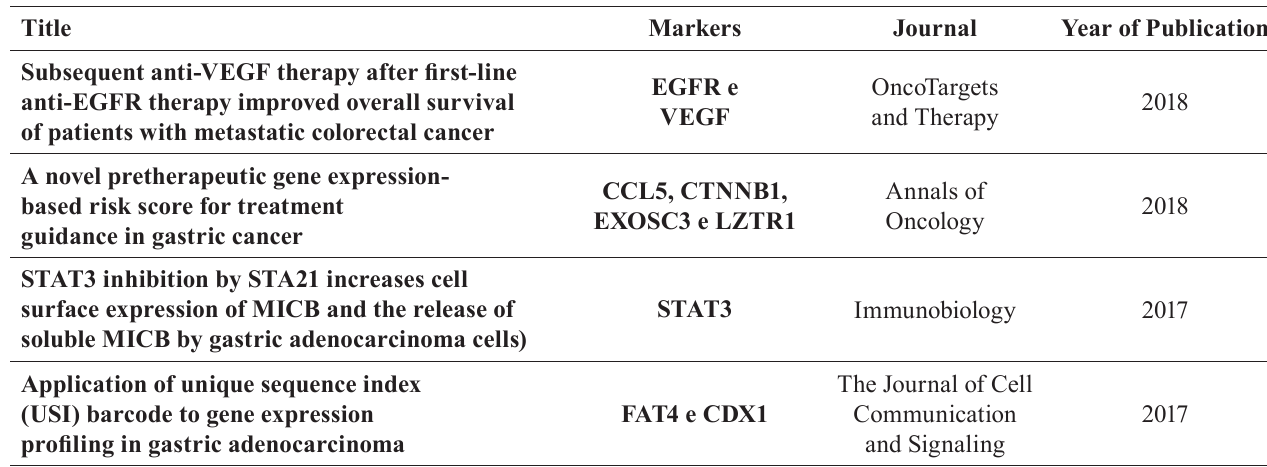
TABLE I - T umor targets of CRC identified in articles searched in PubMed, with their respective journals and year of publication